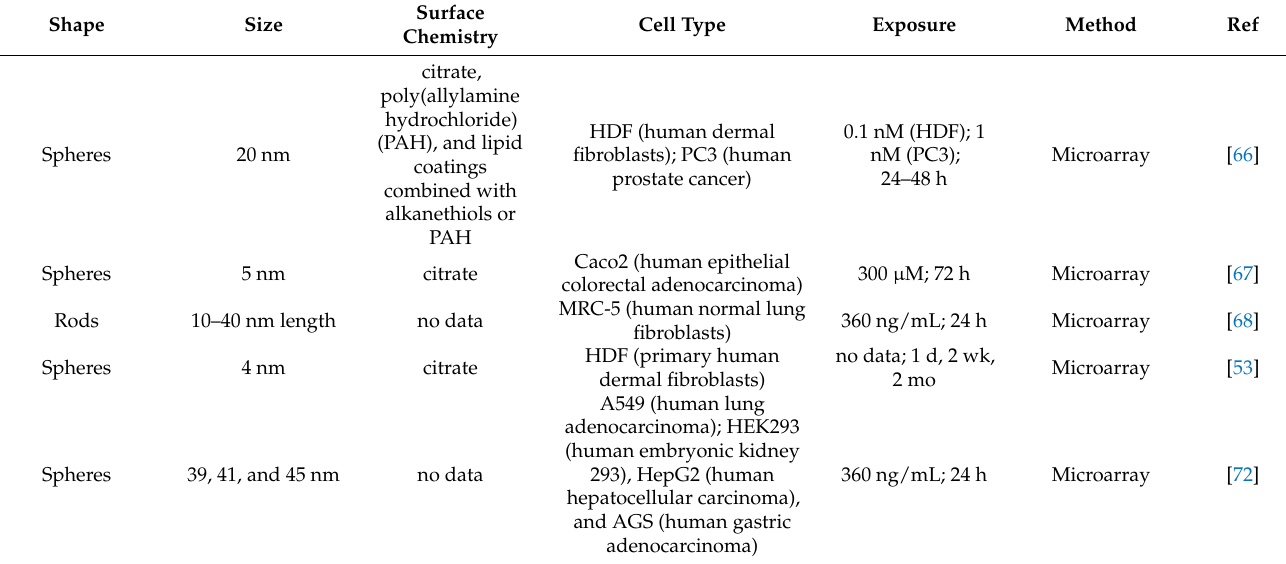
Table 2. Examples of transcriptomic changes induced by AuNPs in